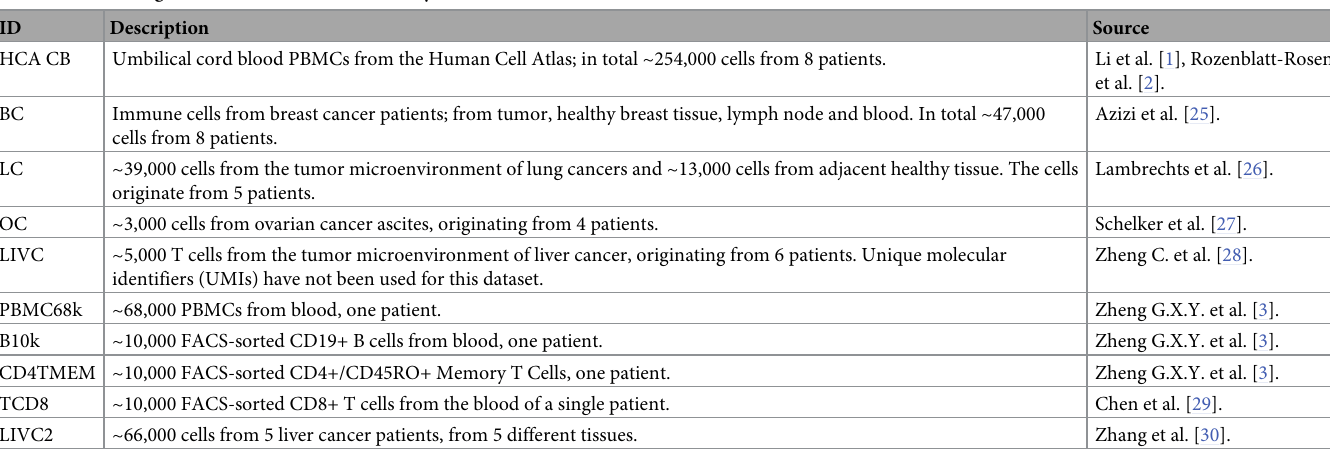
Table 1. List of single-cell datasets used in this